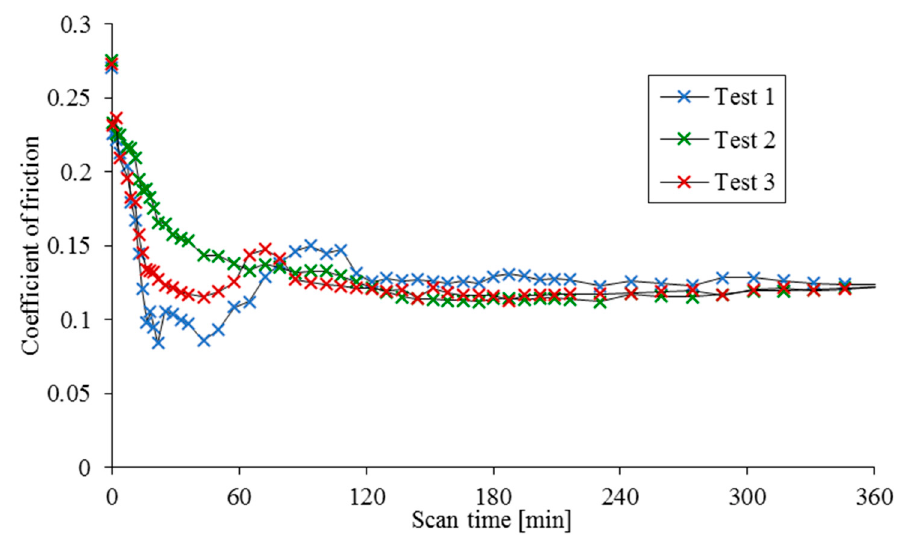
Figure 3. Measured coefficient of friction data from three scanned areas on the EN31 steel sample with base oil containing MoDTC.